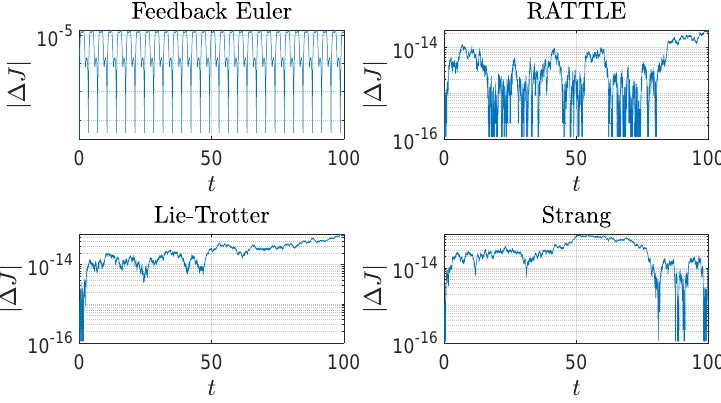
Figure 5. The trajectories of the momentum error, | ∆ J ( t ) | = | J ( t ) − J ( 0 ) | , 0 ≤ t ≤ 100, of the spherical pendulum generated by four different methods with step size h = 10 − 3 : a feedback integrator with the Euler scheme, the RATTLE method, the Lie–Trotter method, and the Strang method. A logarithmic scale is used on the y